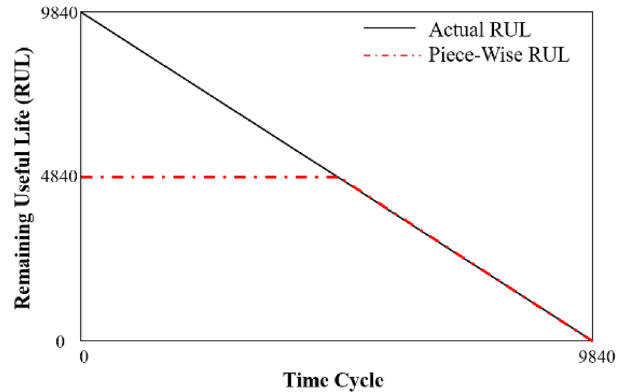
Figure 6. Piece-wise RUL.